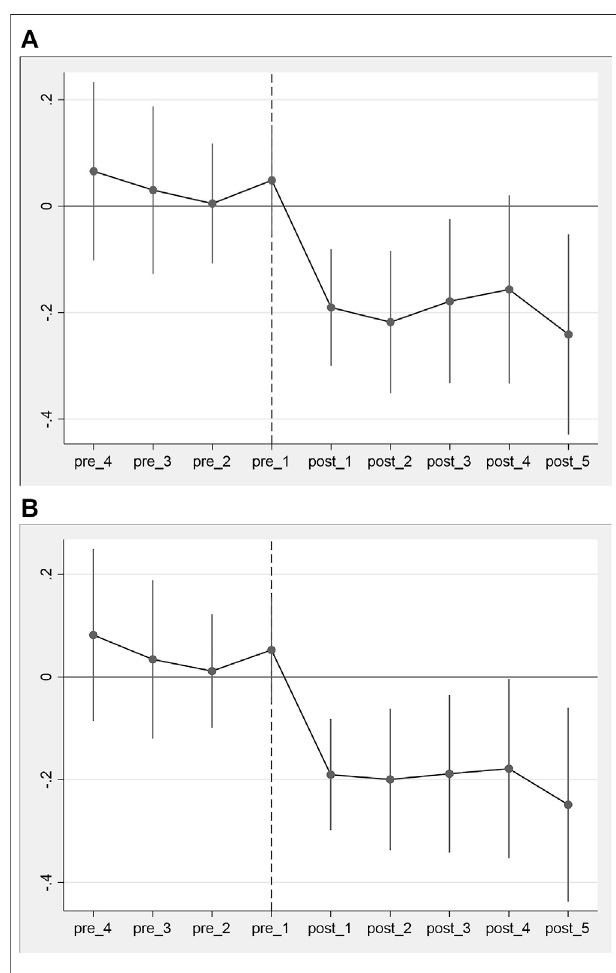
FIGURE 1 | Parallel trend test (A) : Parallel trend test for export (B) : Parallel trend test for export per capita.